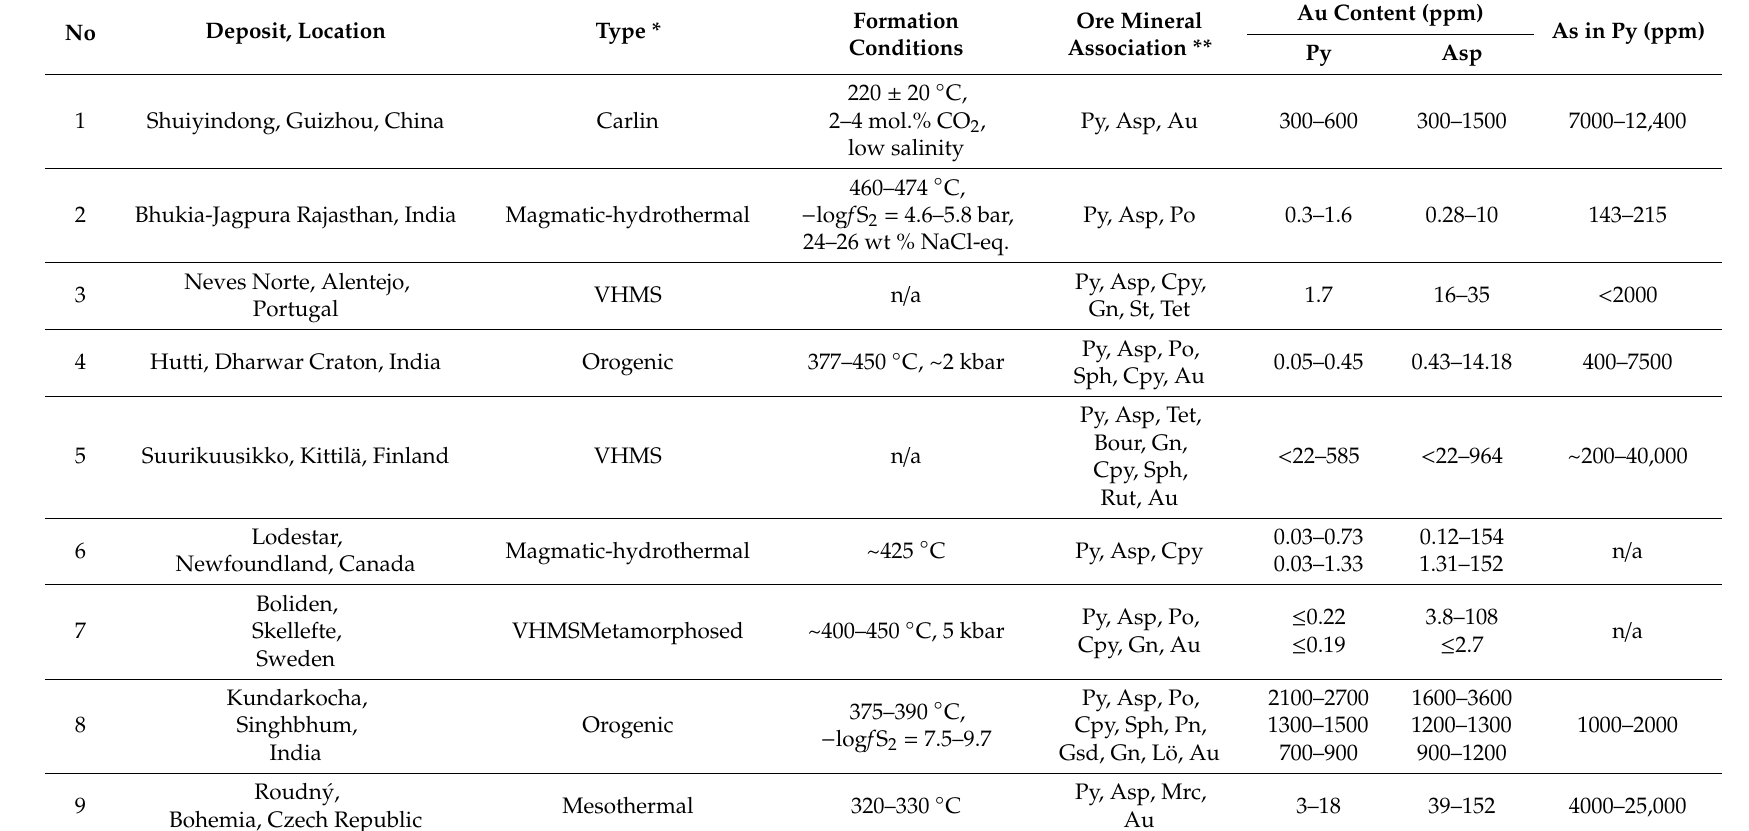
Table 1. Literary data on “invisible” gold in coexisting pyrite and